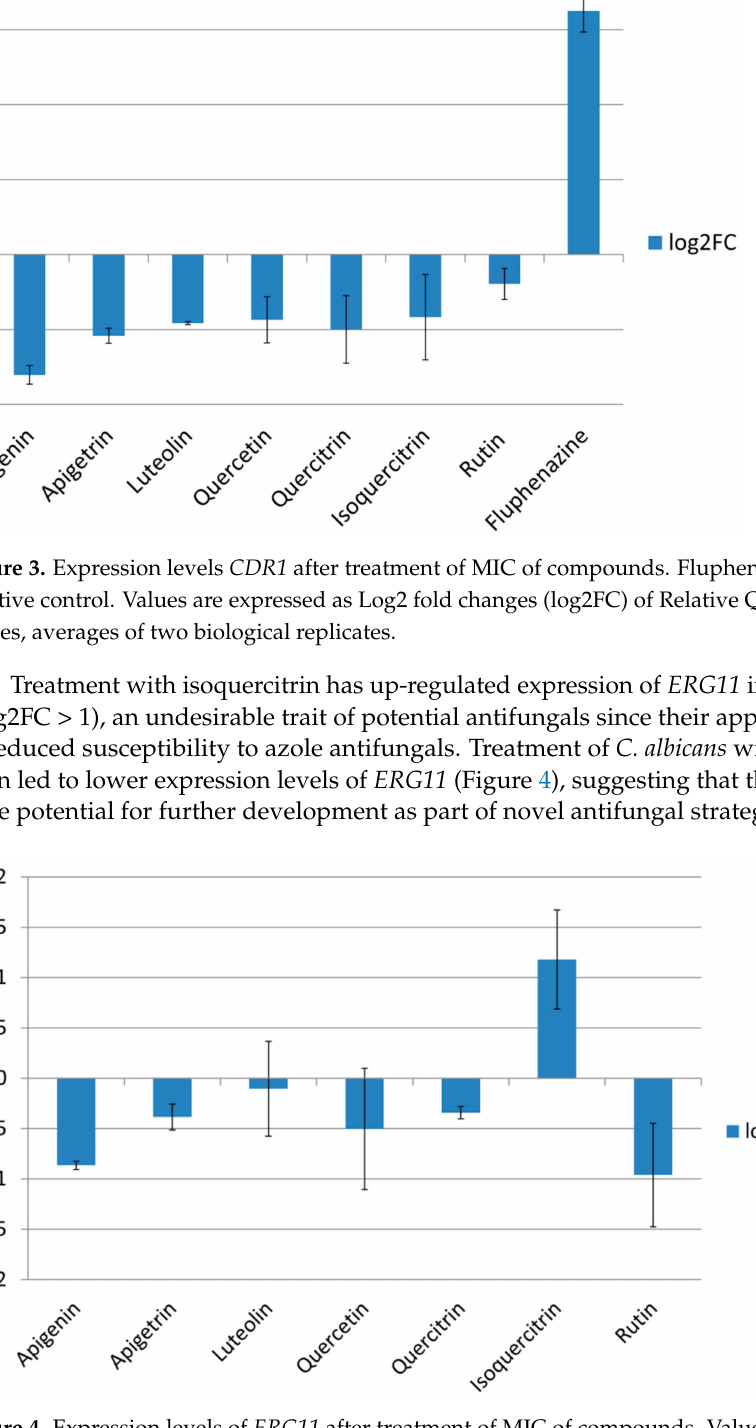
Figure 4. Expression levels of ERG11 after treatment of MIC of compounds. Values are expressed as Log2 fold changes of RQ values, averages of two biological